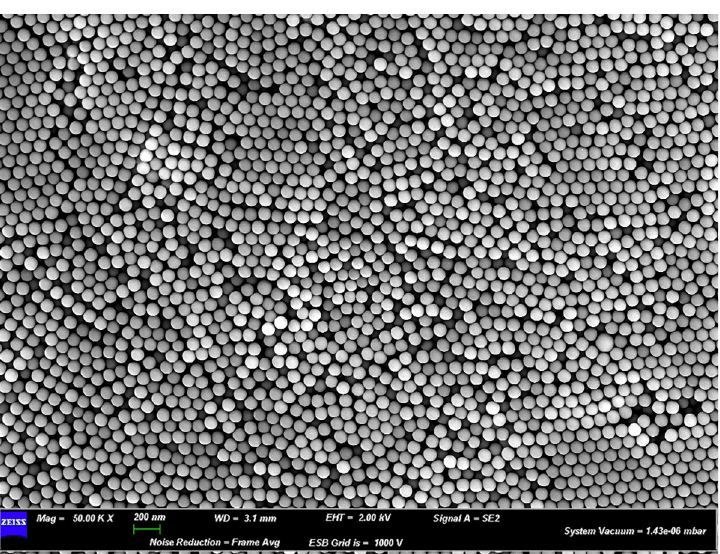
Fig 1. Scanning electron microscopy (SEM). Polystyrene Nanoparticles morphological analysis with SEM.